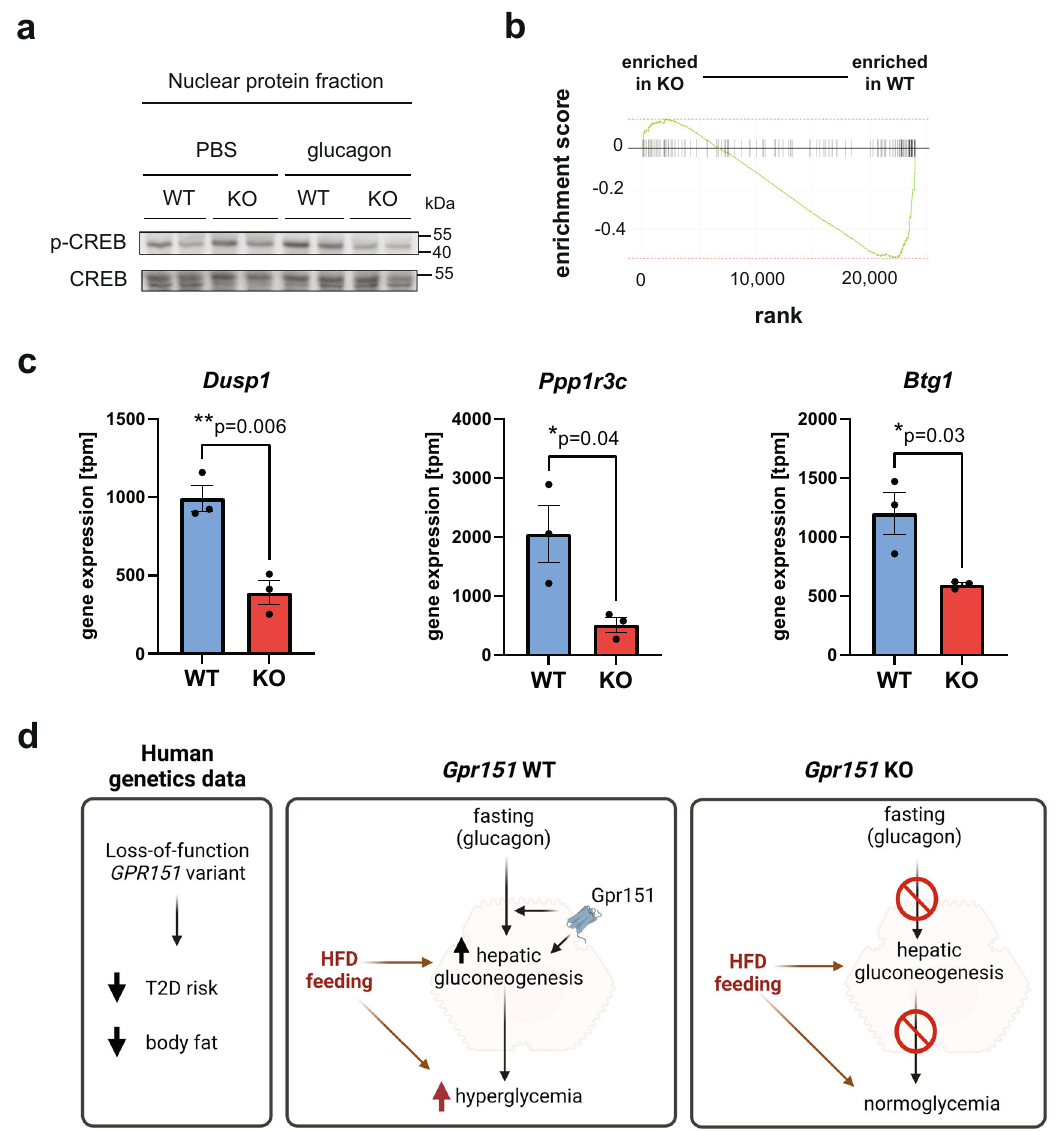
Fig. 5 | Gpr151 loss results in a downregulation of cAMP-dependent gene expression. a Western blotting of phosphorylated CREB and total CREB in the nuclear protein fraction isolated from the livers of PBS- and glucagon-injected Gpr151 WT and KO eight-week-old male mice. Samples were run on the same blot. Results of one experiment representative of two independent experiments. b The results of custom gene set enrichment analysis of liver expression of 127 cAMP-